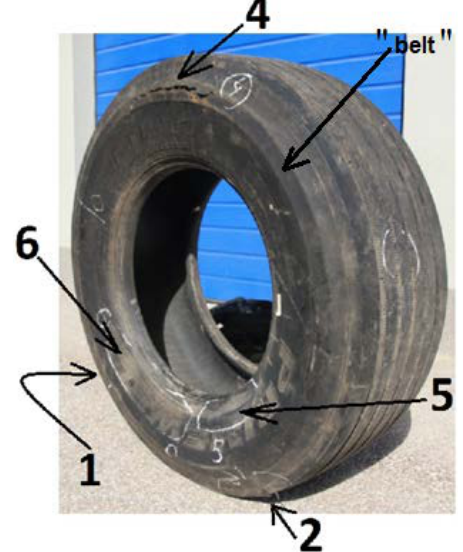
Figure 5. View of the inside of the tire of the left front wheel of a truck tractor.